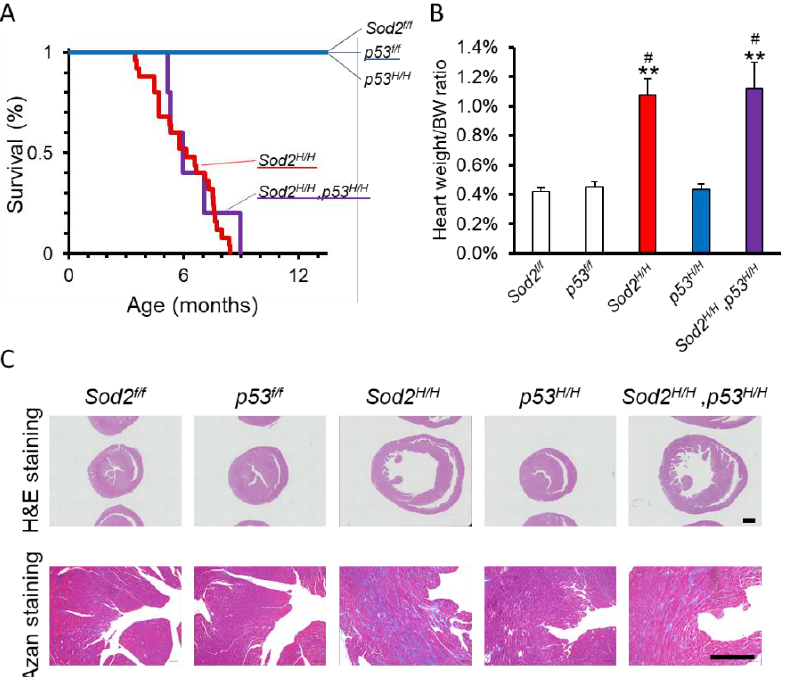
Figure 4. The mitochondrial SOD (SOD2)-deficient phenotypes were largely unaffected by p53 loss. ( A ) A comparison of the survival curves in each mouse. A Kaplan–Meier analysis was used to estimate the median lifespan. The numbers of individuals in each group were as follows: Sod2 f / f ( n = 8); p53 f / f ( n = 8); Sod2 H / H ( n = 7); p53 H / H ( n = 6); Sod2 H / H , p53 H / H ( n = 11). ( B ) The ratio of heart weight corrected by body weight. ( C ) Hematoxylin and eosin staining as well as Azan staining of the heart of each mouse. Statistical analyses were performed using a two-way analysis of variance. The error bars indicate the standard deviation. ** p < 0.05 vs. Sod2 f / f , and # p < 0.05 vs. p53 f / f . The scale bars represent 1 mm (( C ), upper panel) and 500 μm (( C ), lower panel).